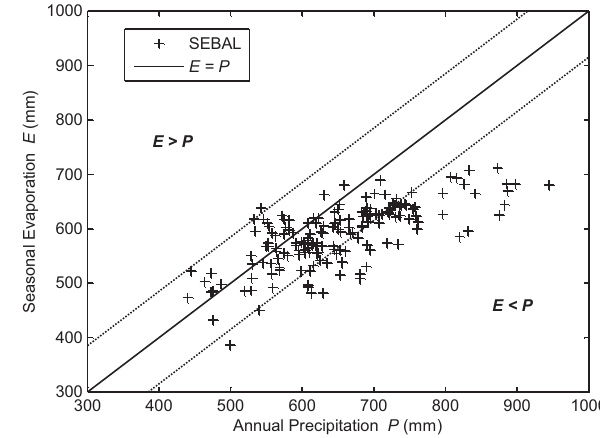
week period in 2005 starting at week 13 and ending at week 43 and annual TRMM precipitation P (mm) over 2005 for each grid cell in the test region. Each point represents a grid cell. The line E = P is given for reference as well as the dotted lines representing E = P ± the standard error of corrected TRMM P